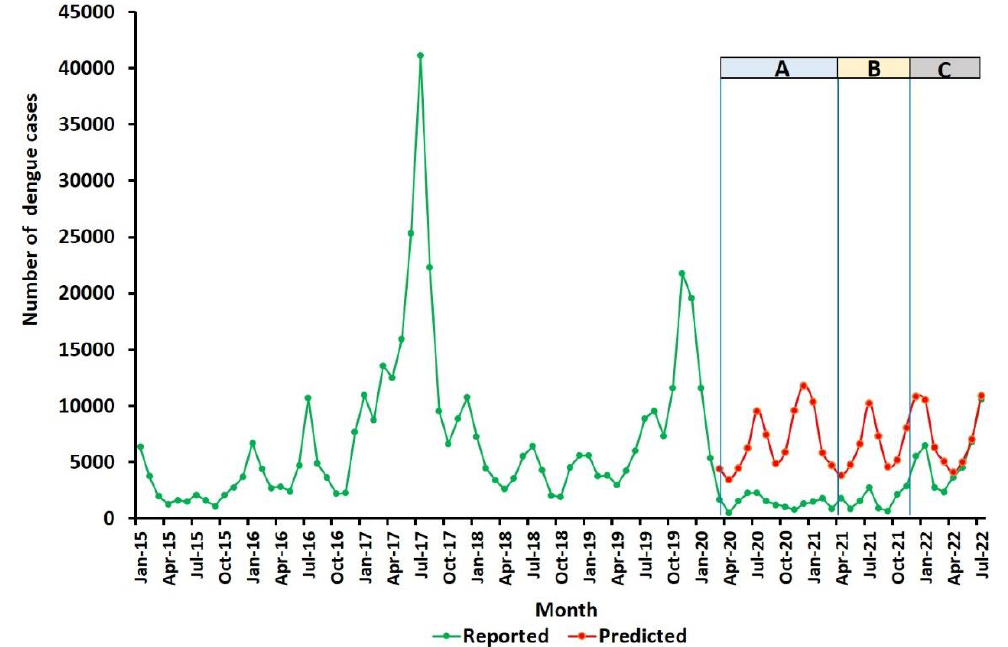
Figure 2. Country-wide predicted and actual numbers of dengue cases in Sri Lanka. Colour coding for periods A, B, and C is the same as in Table 1.